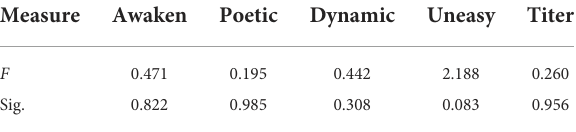
TABLE 4 Homogeneity test of